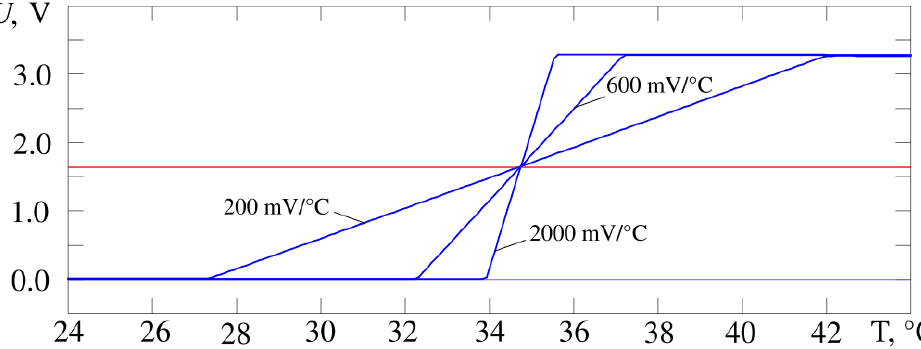
Figure 5. The output characteristics of the thermometer circuit (blue curves) from Figure 4, gain of cascade on Op Amp X2 is changed by a factor of 10. The operating point voltage passes at the level of the middle of dynamic range at the level of 1.64 V (red line).